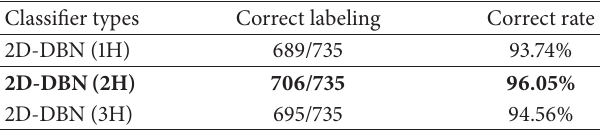
Table 1: Detection results of three different architectures of 2D-